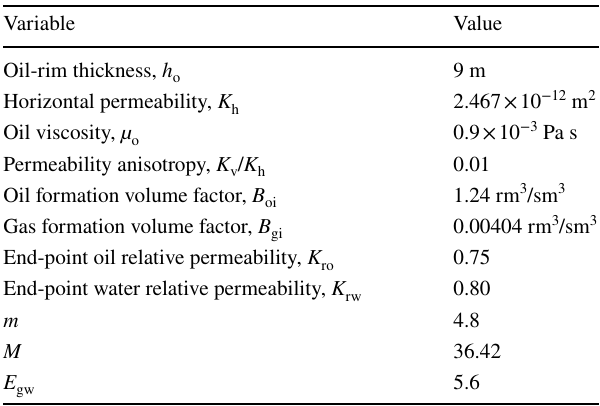
Table 4 Summary of E1 reservoir model